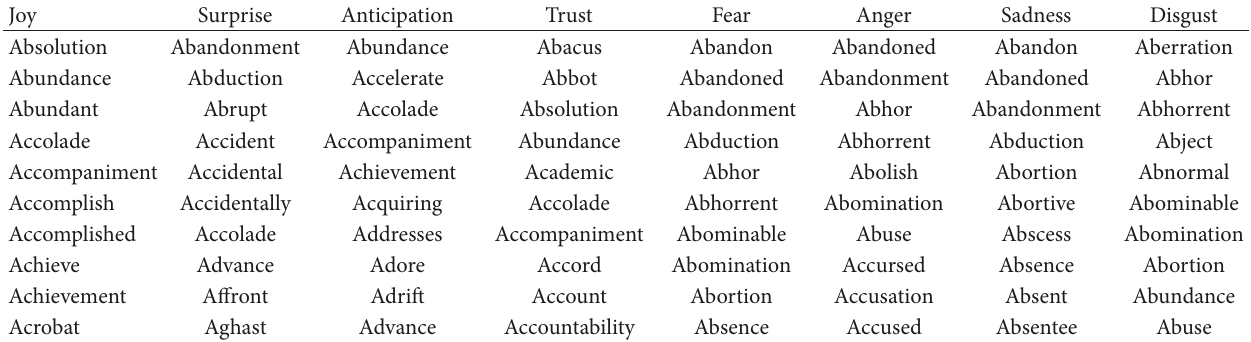
Table 2: Extract from the emotion lexicon used in the